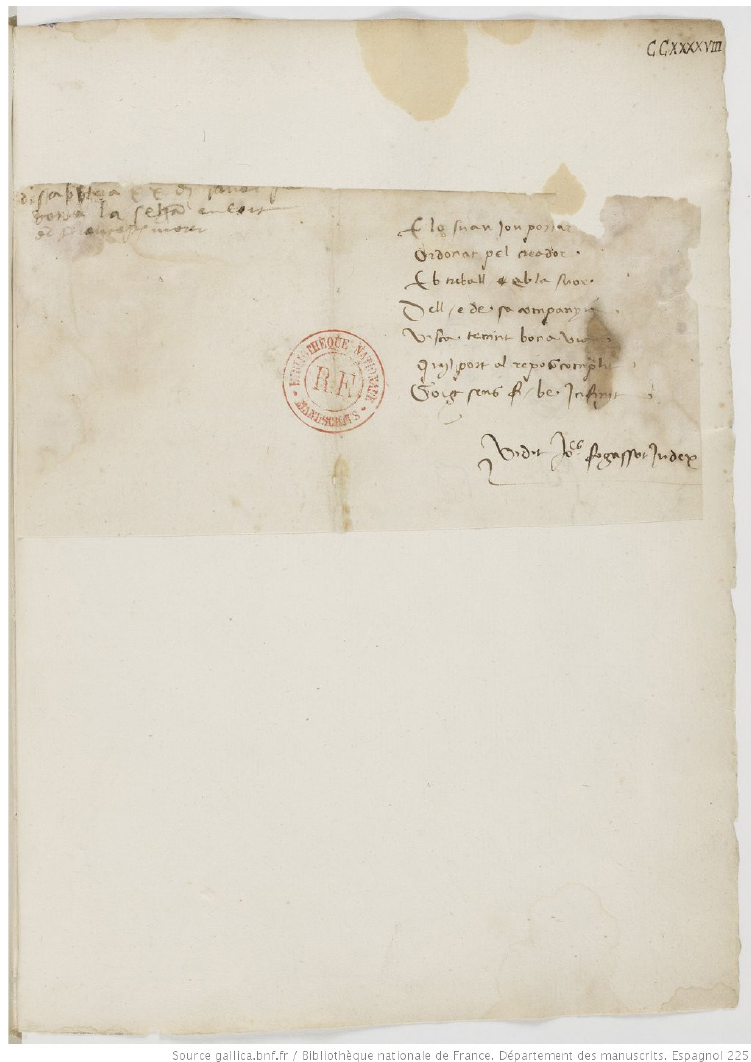
Fig. 3: París, Bibliothèque nationale de France, ms. espagnol 225, fol. ccxxxxviii recto. Font: gallica.bnf.fr / Bibliothèque nationale de